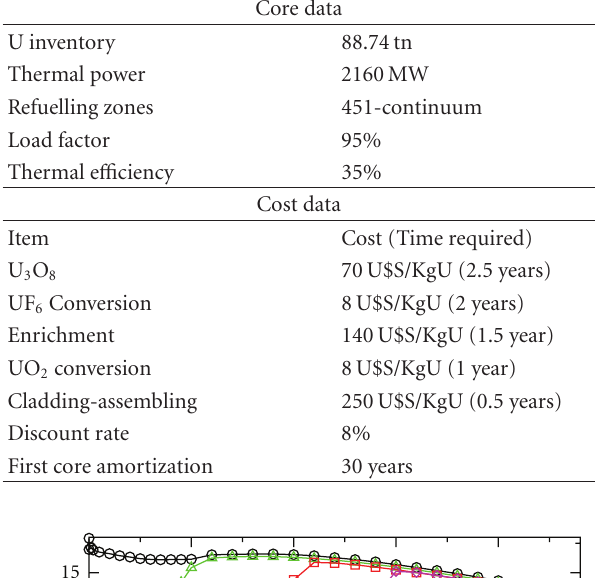
Table 3: Data used for cost evaluation.